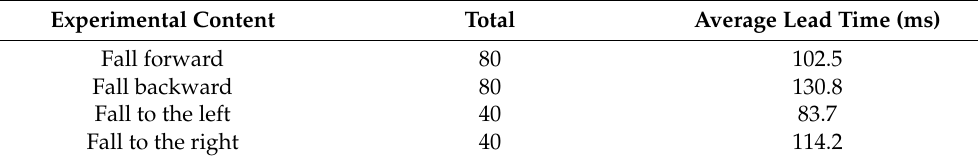
Table 8. Test results for the lead time of